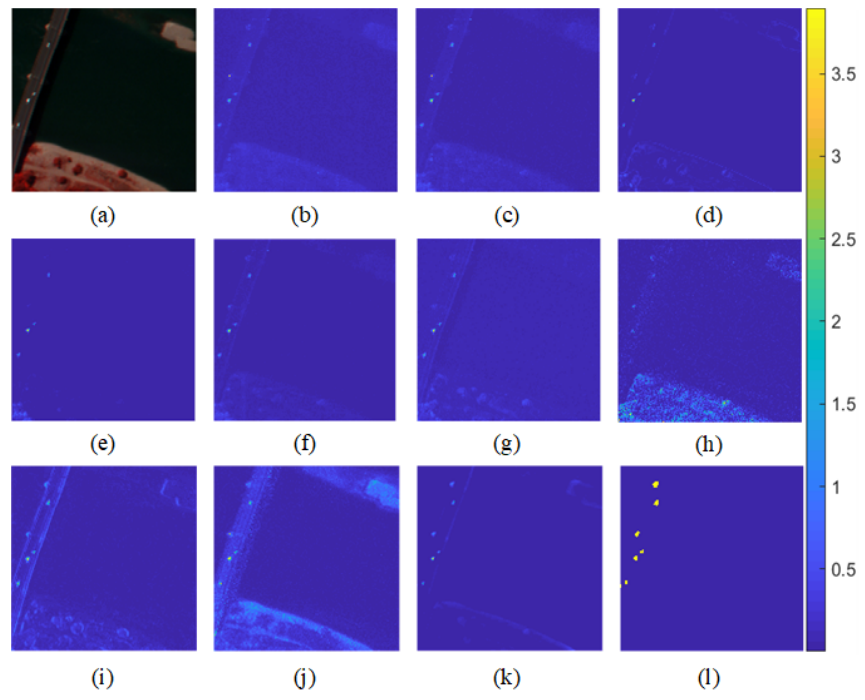
Figure 11. Detection results on the Pavia Centre dataset: ( a ) Pseudo-color image; ( b ) RX; ( c ) RX-DWT; ( d ) RX-Kernel; ( e ) RPCA; ( f ) LSMAD; ( g ) LRASR; ( h ) FrFE; ( i ) GTVLRR; ( j ) FEBPAD; ( k ) proposed method; ( l ) ground